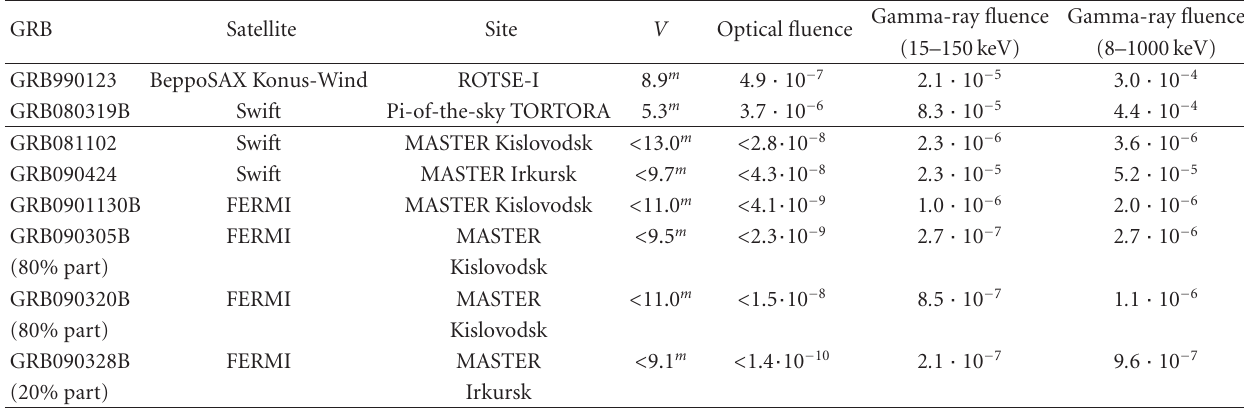
Table 2: Prompt grb